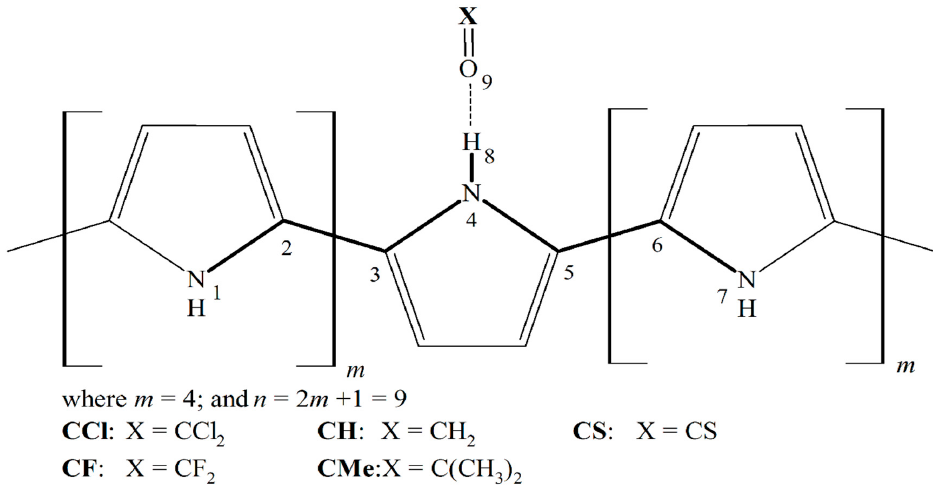
Figure1. Chemicalstructuresofthe(9Py-HC)pyrrole–heterocarbonylgascomplexesandthenumbering Figure 1. Chemical structures of the (9Py-HC) pyrrole–heterocarbonyl gas complexes and the scheme used in this numbering scheme used in this study.